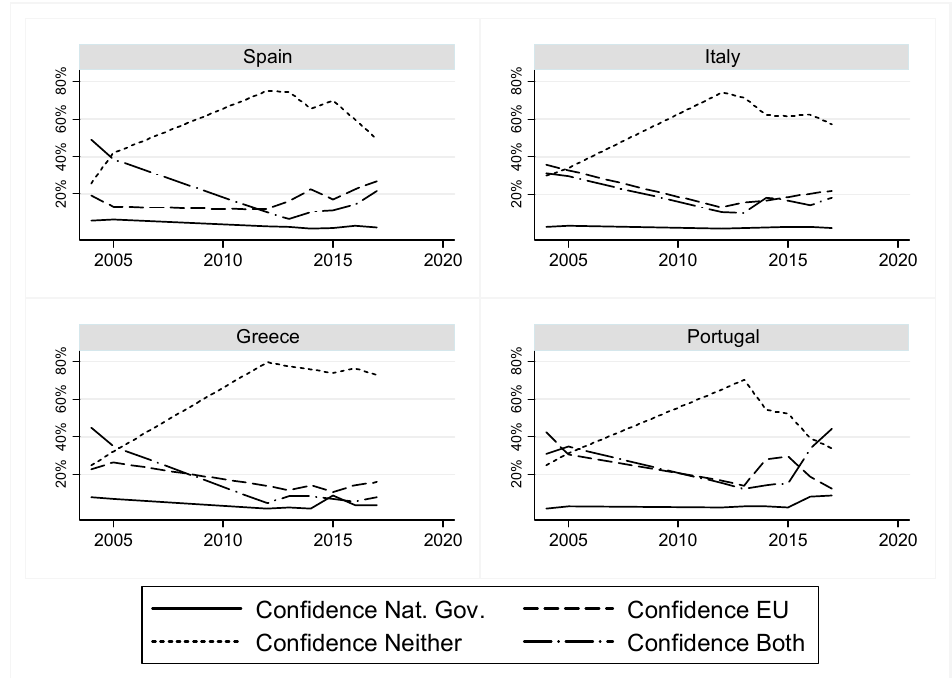
Figure 2. Evolution of the confidence in the national government, the EU, in both, and in neither, in Spain, Italy, Greece and Portugal (2004–2017). Source: Own elaboration from Eurobarometer Note: Column percentage of differential confidence (variable created taking into account confidence in national government and confidence in EU).